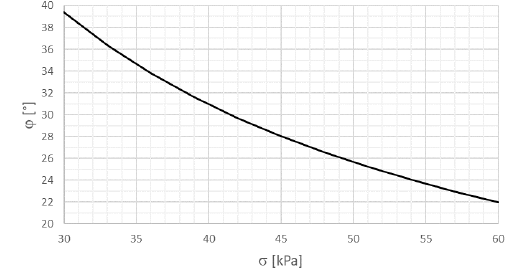
Figure 9. The graph of combinations of values σ and φ satisfying formula